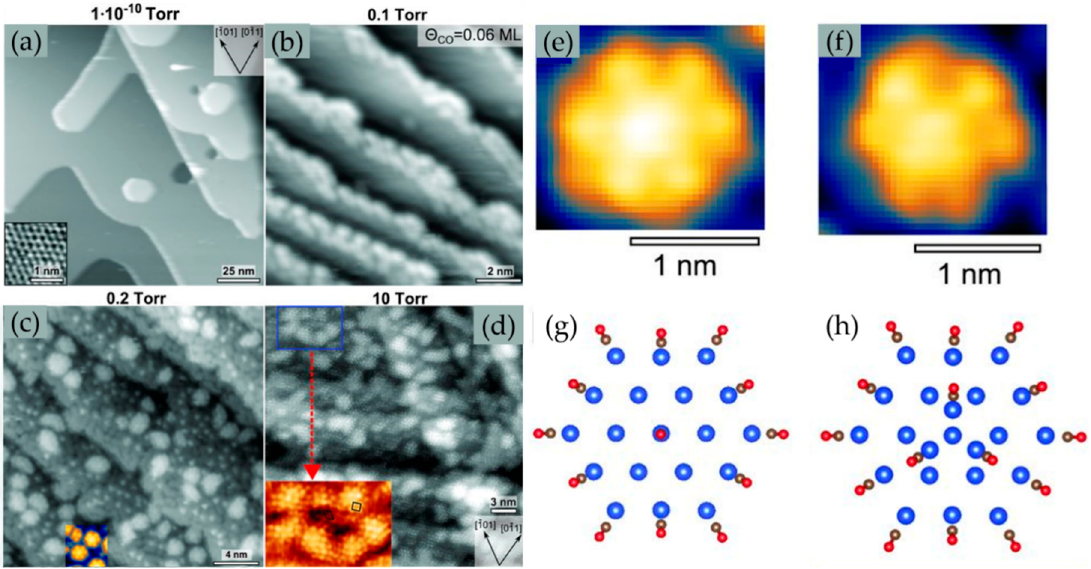
Figure 4. STM images of Cu (111) showing clusters filling the terraces as a function of ambient CO pressure. ( a ) In 1 × 10 − 10 Torr. (Bottom inset) Atomically resolved image. ( b ) Under 0.1 Torr of CO, clusters form at step edges. ( c ) Under 0.2 Torr of CO, clusters form on the terraces. ( d ) Under 10 Torr of CO, a high density of clusters with adsorbed CO molecules (expanded in the inset) completely covers the surface. ( e ) and ( f ) are enlarged images of clusters with C6 symmetry or C 3 symmetry. ( g ) and ( h ) are density functional theory (DFT)-optimized cluster models of ( e ) and ( f ).